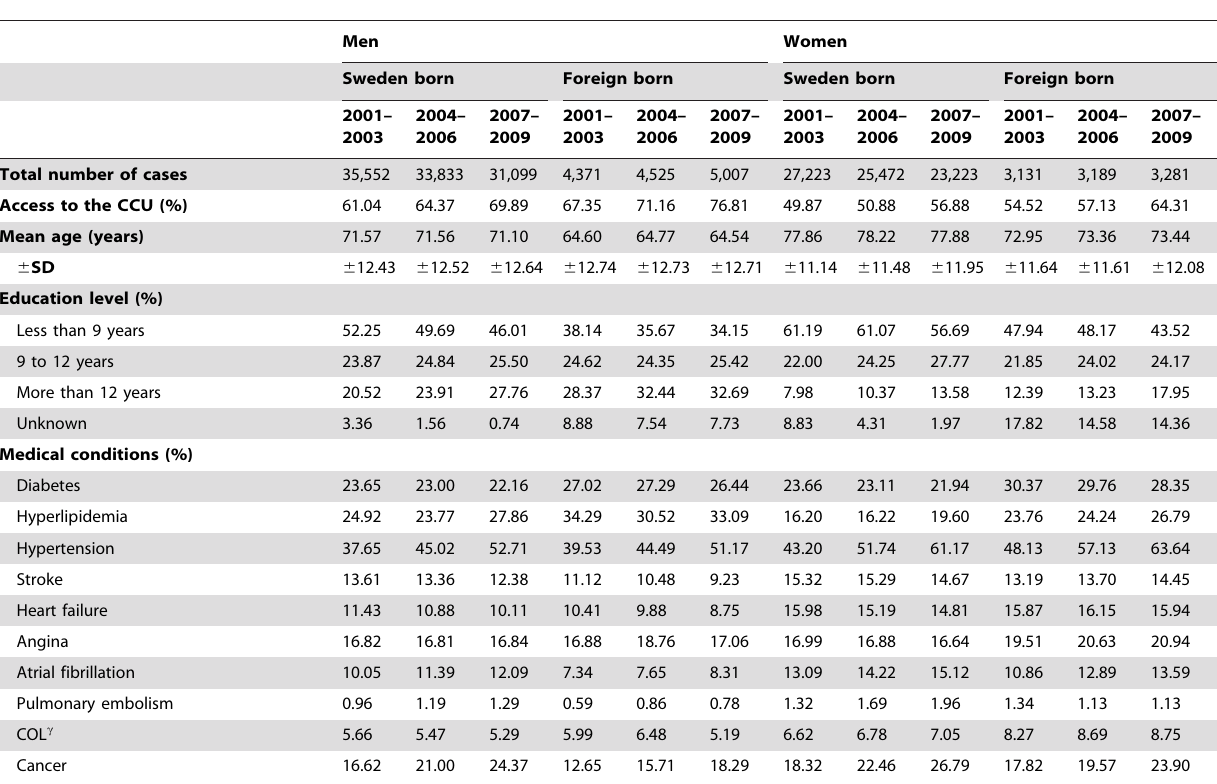
Table 1. Characteristics of patients with first-time myocardial infarction (MI) living in Sweden between 2001 and 2009, by sex, country of birth, and study